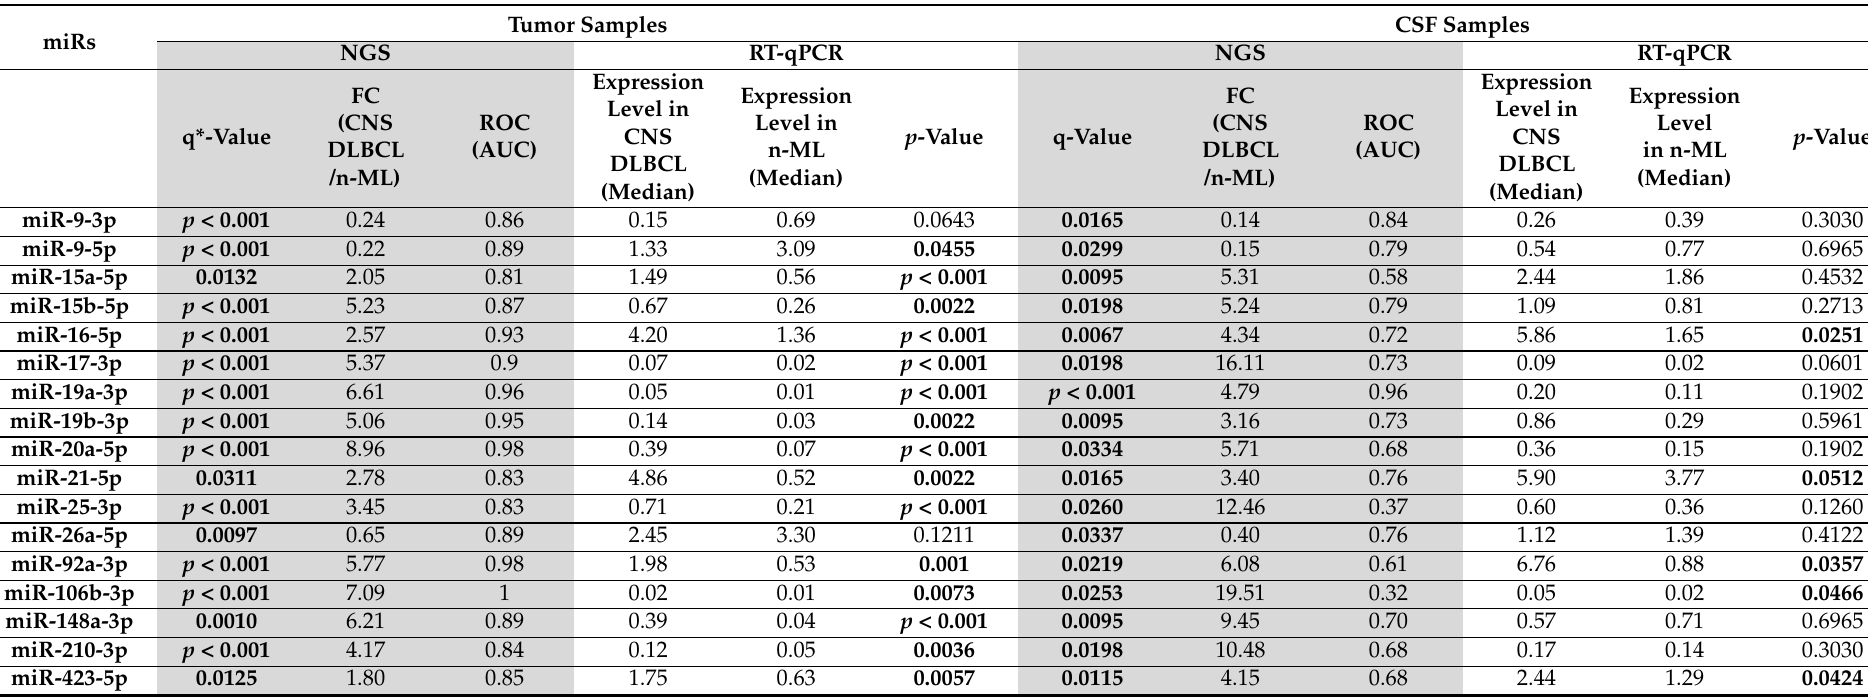
Table 3. Seventeen miRs common for cerebrospinal fluid and tumor samples, significantly differentiating CNS DLBCL and n-ML tumors. RT-qPCR validation of the NGS results. Tumor